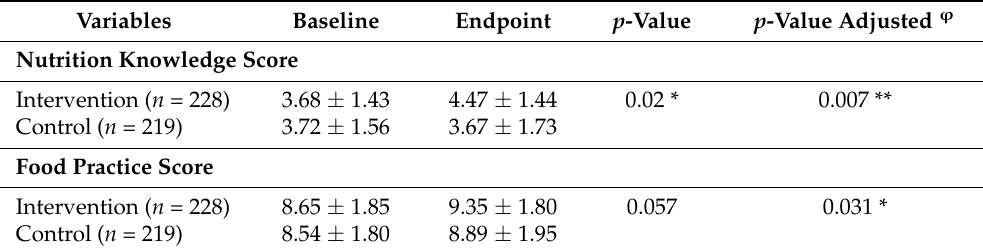
Table 4. Results of effectiveness of the conditional cash transfer (CCT) intervention on nutrition knowledge and food practice scores for